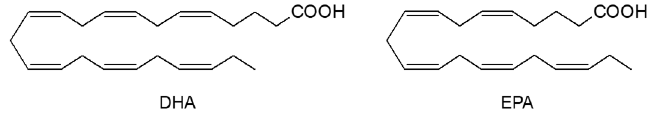
Figure 1. Chemical structures of docosahexaenoic acid (DHA) and eicosapentanoic acid (EPA).